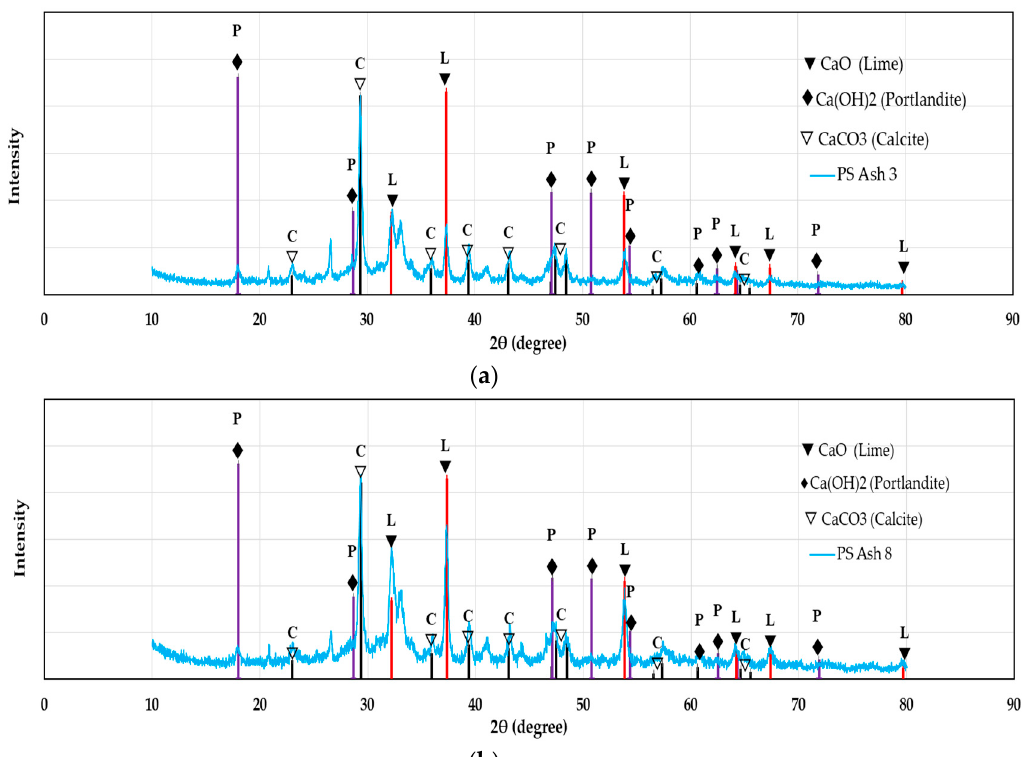
Figure 1. The main calcium compounds in ( a ) PS ash 3 and ( b ) PS ash 8 by XRD (x-ray diffraction) analysis.